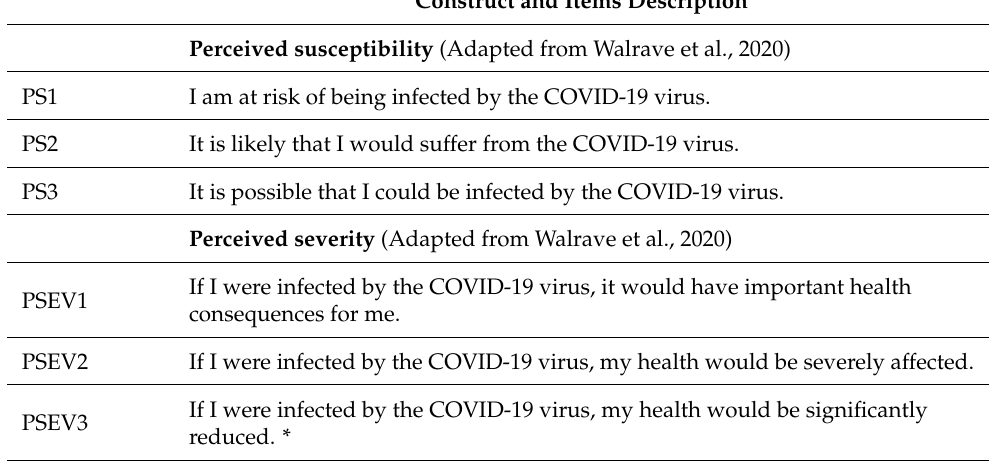
Table A1. Construct and items description.